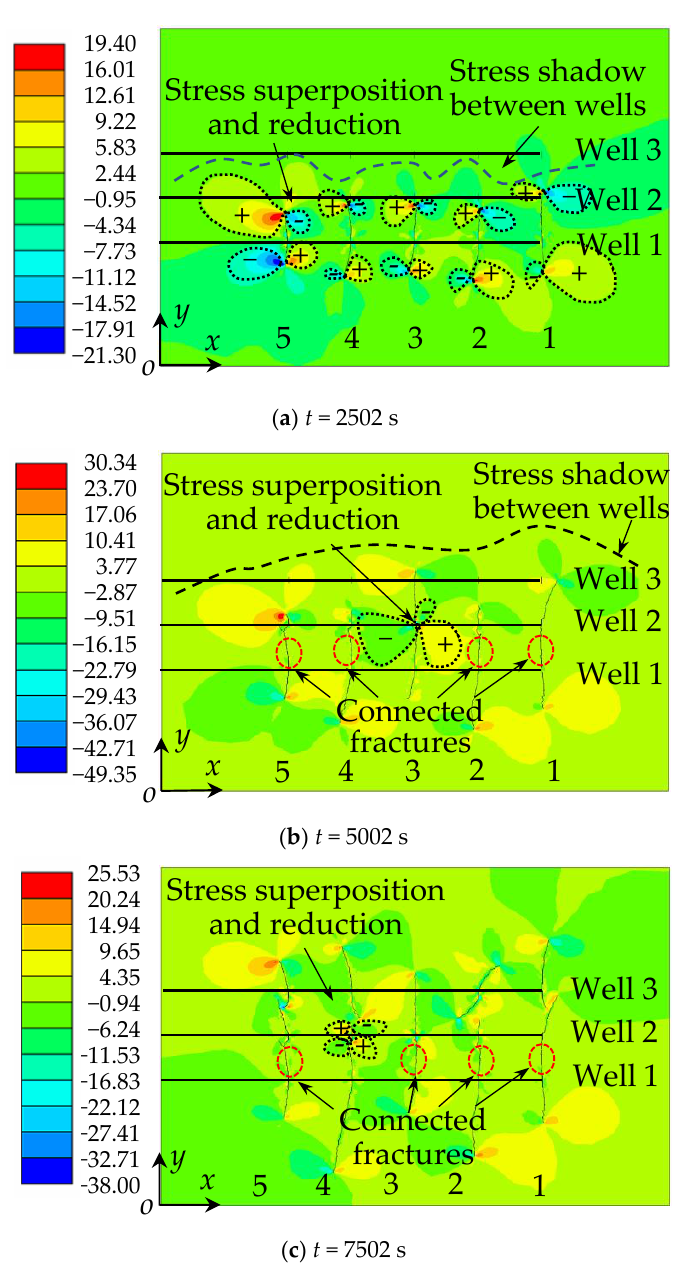
 (Mpa) in sequential fracturing at 50 m well spacing. Figure 12. Evolution of shear stress Figure 12. Evolution of shear stress τ xy (Mpa) in sequential fracturing at 50 m well xy